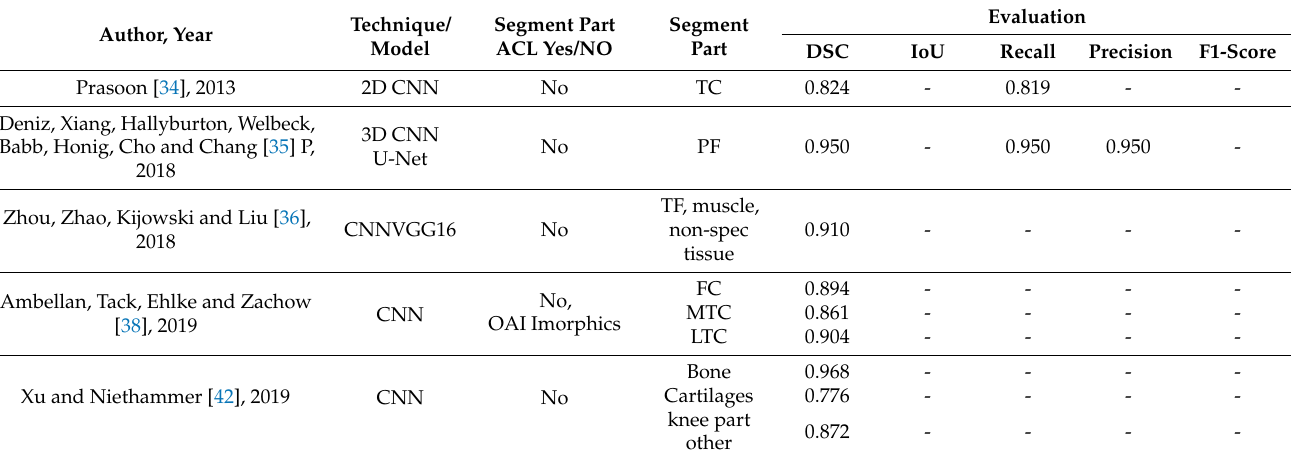
Figure 10. After testing actual knee mask and predicted mask. Table 4 describes the state-of-art work comparisons with our segmentation model, and evaluation metrics. Table 4. The segmentation of various knee comparisons with our ACL segmentation.